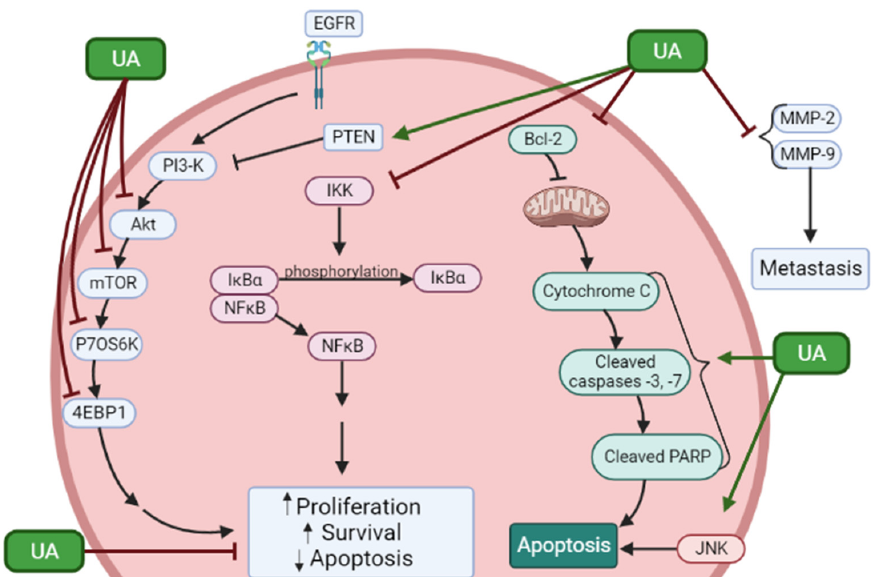
Figure 2. Effects of ursolic acid on signaling molecules in prostate cancer cells. UA reduced proliferation and survival and induced apoptosis of prostate cancer cells. These effects were associated with inhibition of phosphorylation/activation of JNK, Akt, mTOR, p70 S6K, and 4EBP1 and inhibition of the NF- κ B pathway. Increased levels of PTEN and apoptosis markers cleaved caspases and PARP were seen. In addition, UA inhibited MMP-2 and -9 indicating antimetastatic effects. The figure was created using BioRender.com based on the data presented in Table 1. ↑ = Increased; ↓ = Decreased.